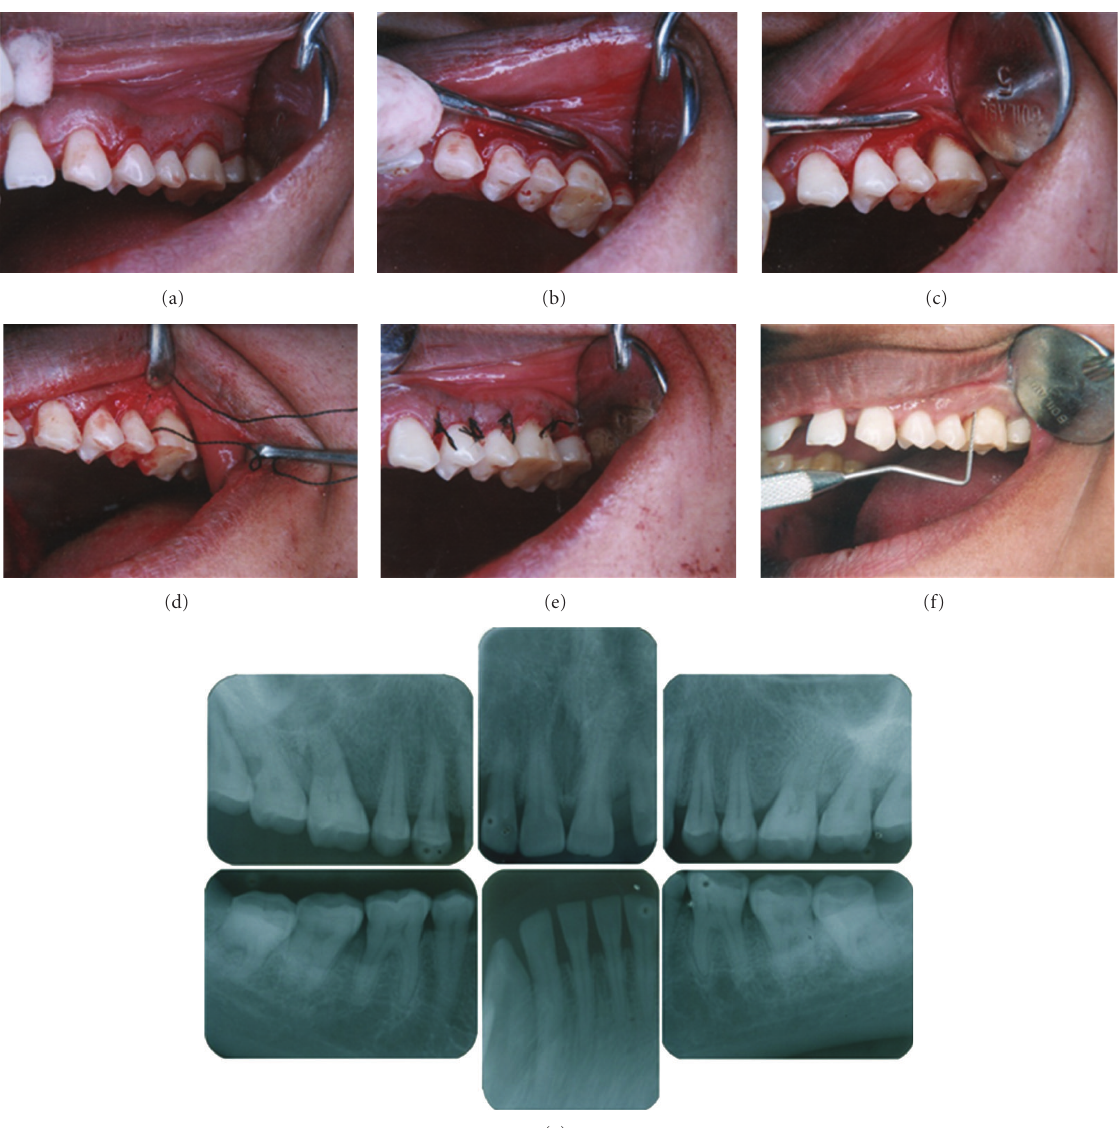
Figure 8: (a)–(e) Modified Widman flap in conjunction with bone grafting performed. (f) Postoperative evaluation showing probing depth within normal limits. (g) 6-Month postoperative intraoral periapical radiographs.